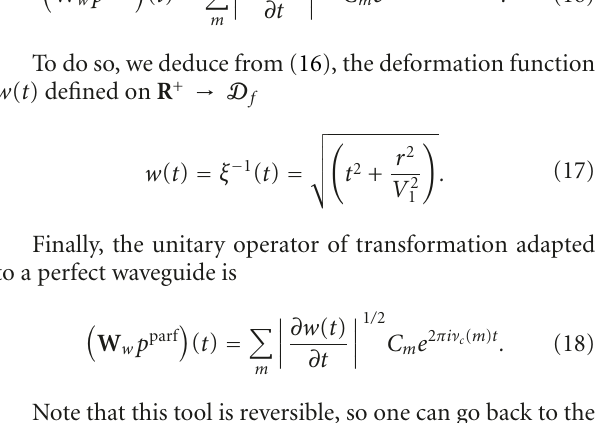
waveguide propagation and build a representation